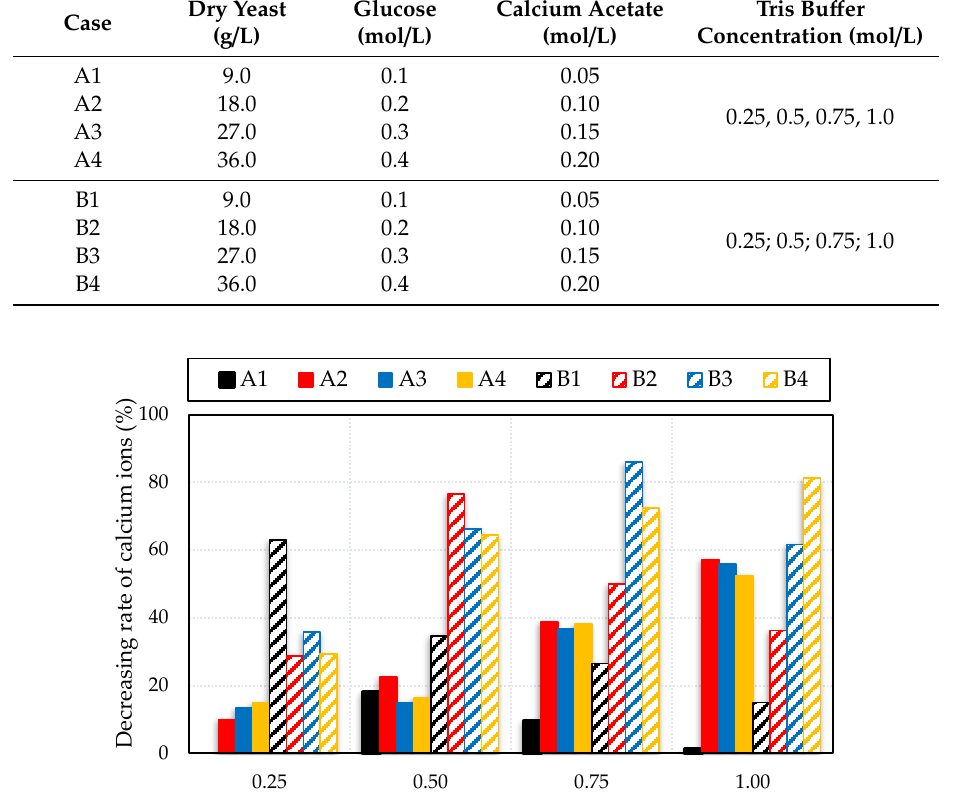
Table 5. The mix proportion of the basic constituents for each group.